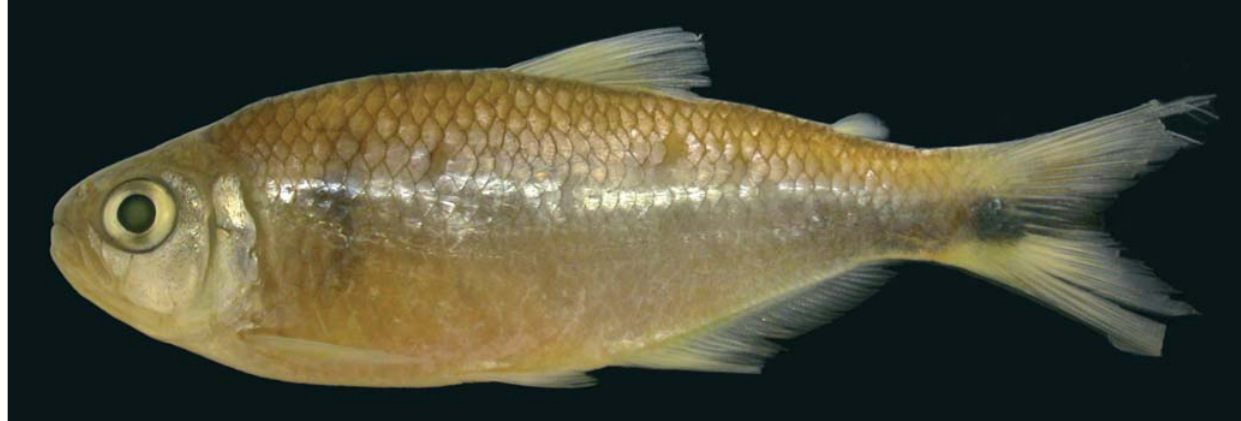
Fig. 2. Hemibrycon divisorensis , MCP 41346, paratype, female, 81.6 mm SL; río Ucayali drainage, Loreto, Peru.